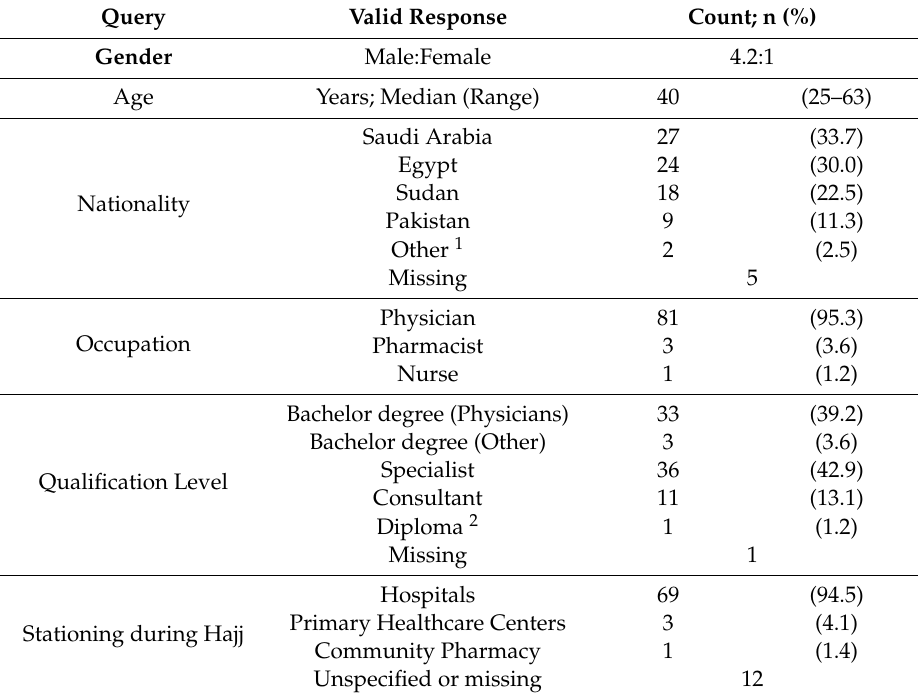
Figure 1. Flowchart for recruitment and analyzed responses. Table 1. Demographics and responses to Hajj deployment related